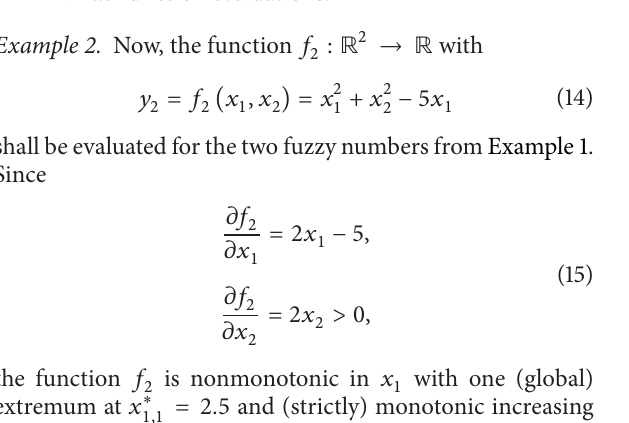
Figure 1: Solution candidates from Example